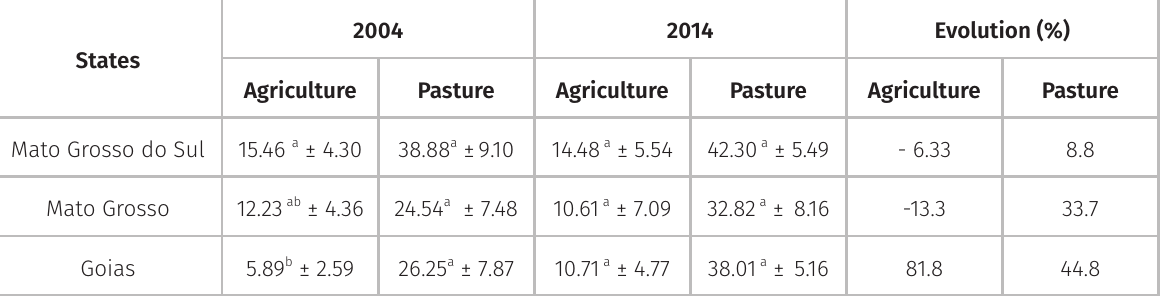
Table II. Mean values in percentage of the agricultural and pasture areas for the settlements of the states in the Brazilian Midwest, in 2004 and 2014, with the standard error of each class.